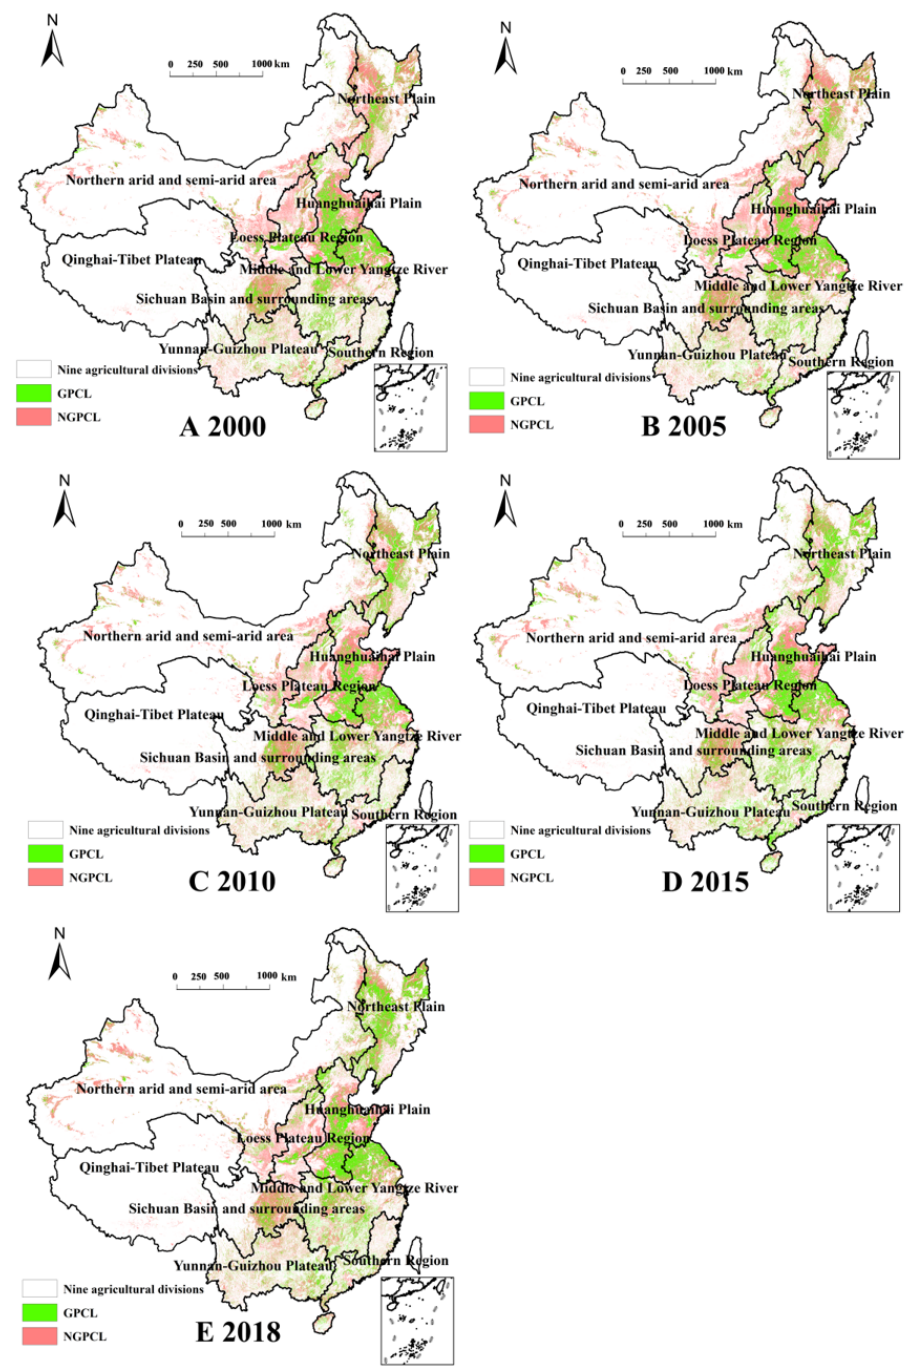
Figure 1. Spatiotemporal distribution of grain-producing cultivated land (GPCL) and non-grain- producing cultivated land (NGPCL) in China from 2000 to